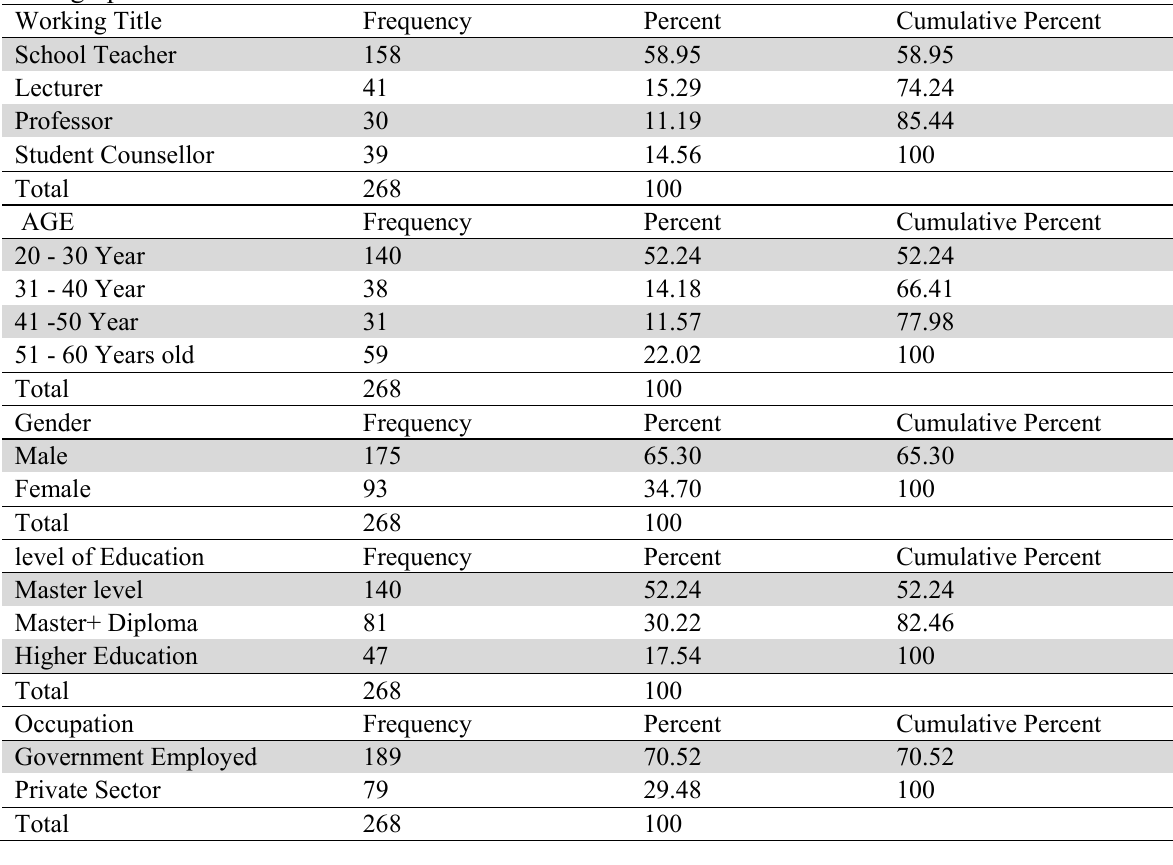
Data screening Details Number of questionnaires Percentage Total questionnaires distributed Total questionnaire